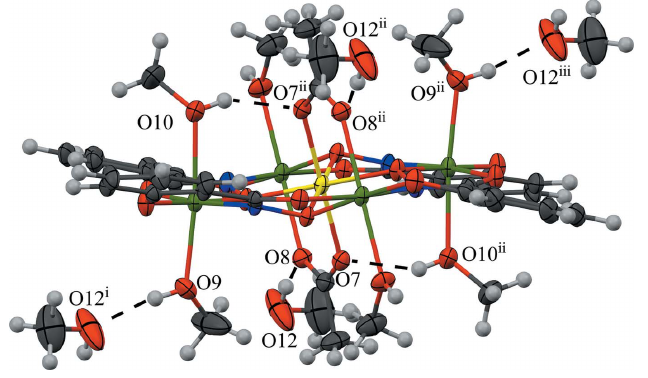
Figure 2 Intramolecular hydrogen bonding (dashed lines) between the coordi- nated methanol molecule (O10) and a carboxylate oxygen atom (O7) of the bridging acetate anion, and intermolecular hydrogen bonding (dashed lines) of the interstitial methanol molecule (O12) with a coordinated methanol molecule (O9) and a carboxylate oxygen atom (O8) of the bridging acetate anion. [Symmetry codes: (i) (cid:3) x + 2, (cid:3) y + 1, (cid:3) z + 1; (ii) (cid:3) x + 1, (cid:3) y + 1, (cid:3) z + 1; (iii) x (cid:3) 1, y , z